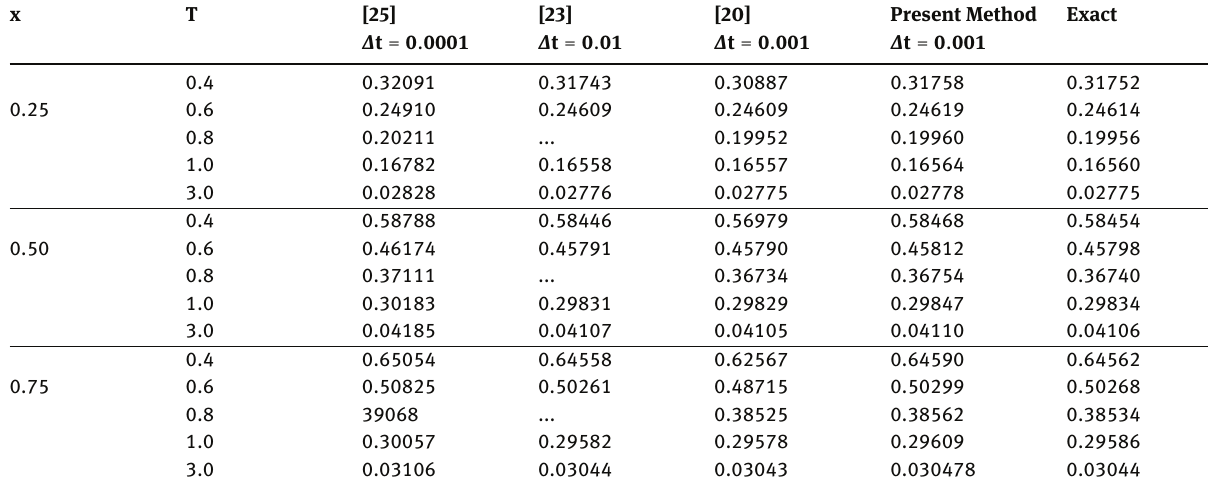
Table 7: Comparison between exact and existing numerical solutions of Example 2 for ν = 0.1 at different times T and x .